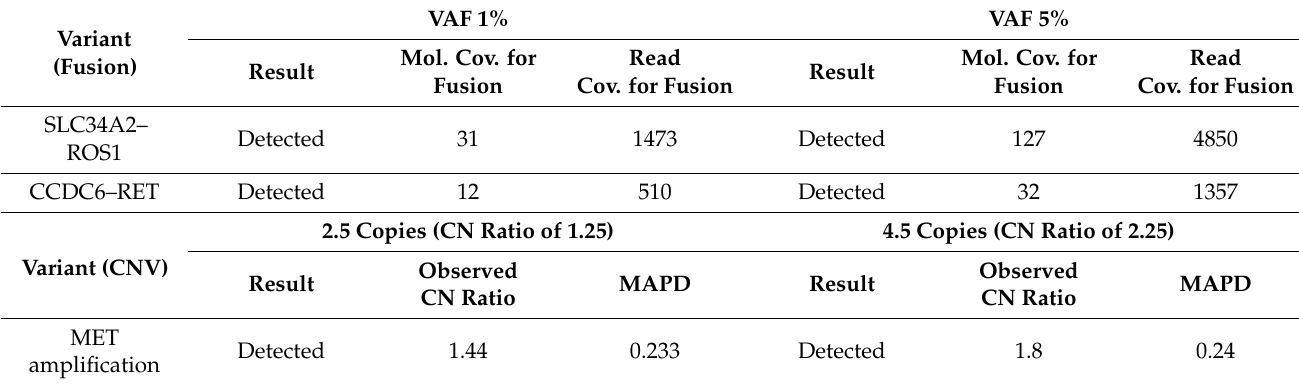
Table 2. Analytical sensitivity for fusion and CNV using the reference